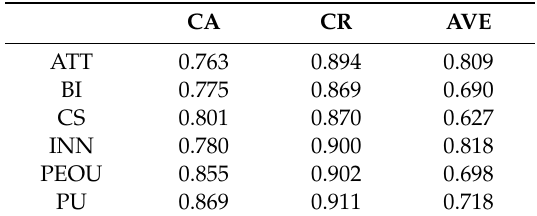
Table 7. Construct reliability.